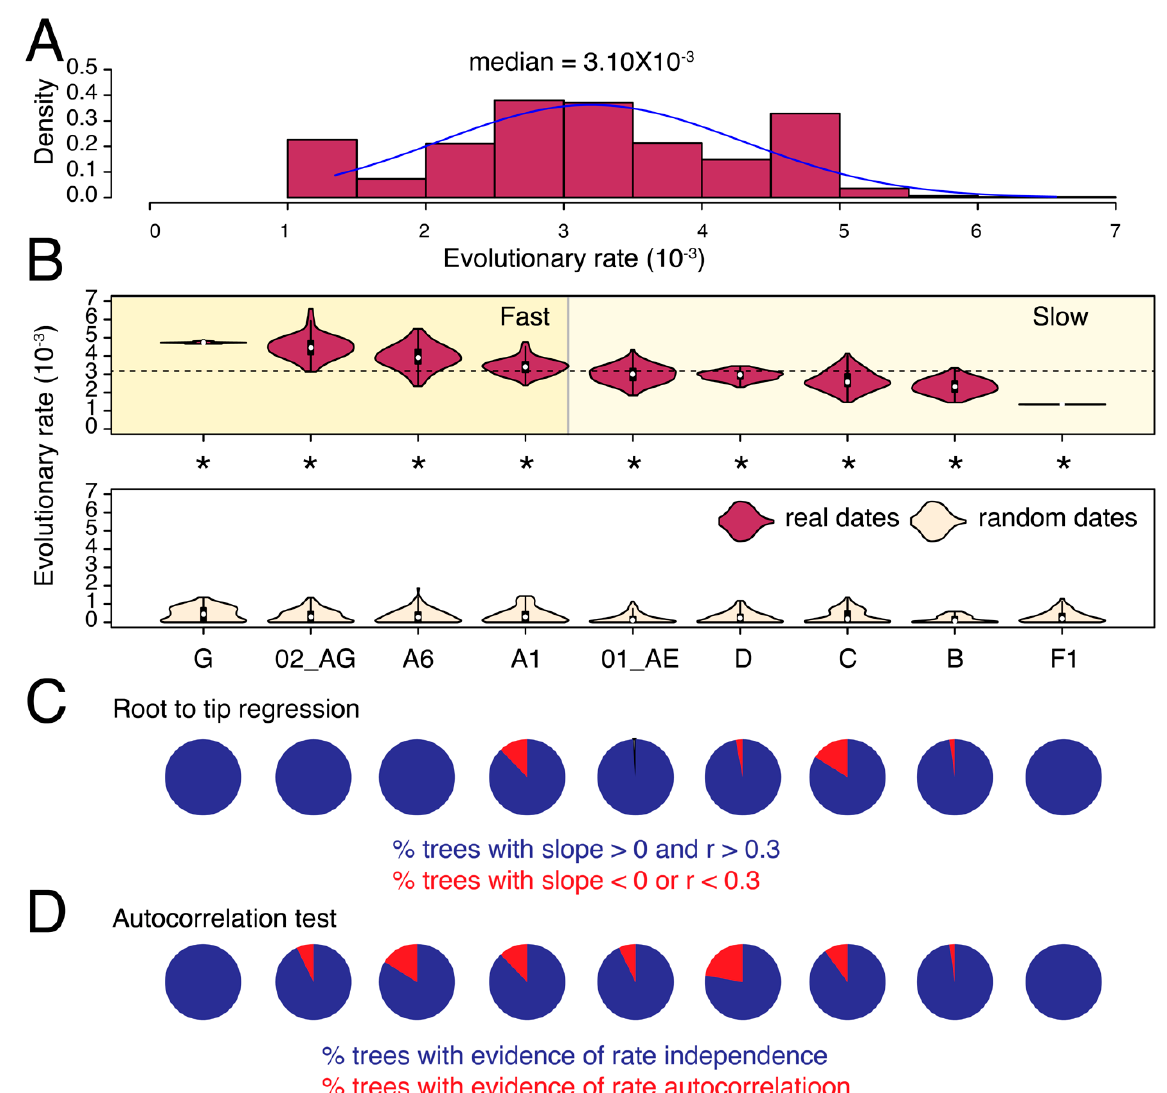
Figure 2. Substitution rate heterogeneity in env . The histogram displays the distribution of calculated substitution rates for all 900 env tree reconstructions. Median of the distribution is listed on the top. ( B ) The violin plots show the distribution of substitution rates calculated individually for each subtype/CRF (i.e., across 100 tree reconstructions). The white circle indicates the group median. The dotted horizontal line represents the global median rate calculated in ( A ). Distributions of substitution rates calculated for trees with real and random dates can be compared. All comparisons were statistically significant (indicated by asterisk). ( C ) Pie-charts show the proportion of phylogenetic trees that failed the RTT tests described in text. ( D ) Pie-charts show the proportion of phylogenetic trees with evidence of autocorrelated rates. The mean and median substitution rates, along with 95% CIs, for each subtype and CRF are also reported in Table 2. Note that Table 2 excludes trees where RTT slope was either negative or r was < 0.3. Table 1. Evidence of temporal signal and autocorrelated rates on phylogenetic trees. The values in the table show how many of the 100 trees for each subtype/CRF failed the RTT test (i.e., either neg- ative slope or r < 0.3) or indicated evidence of autocorrelated rates, tested via the CorrTest program [26]. A6 and A1 are bolded, as >50% of these trees indicated either evidence of rate autocorrelation or failed RTT tests. See Table S1 for complete data.